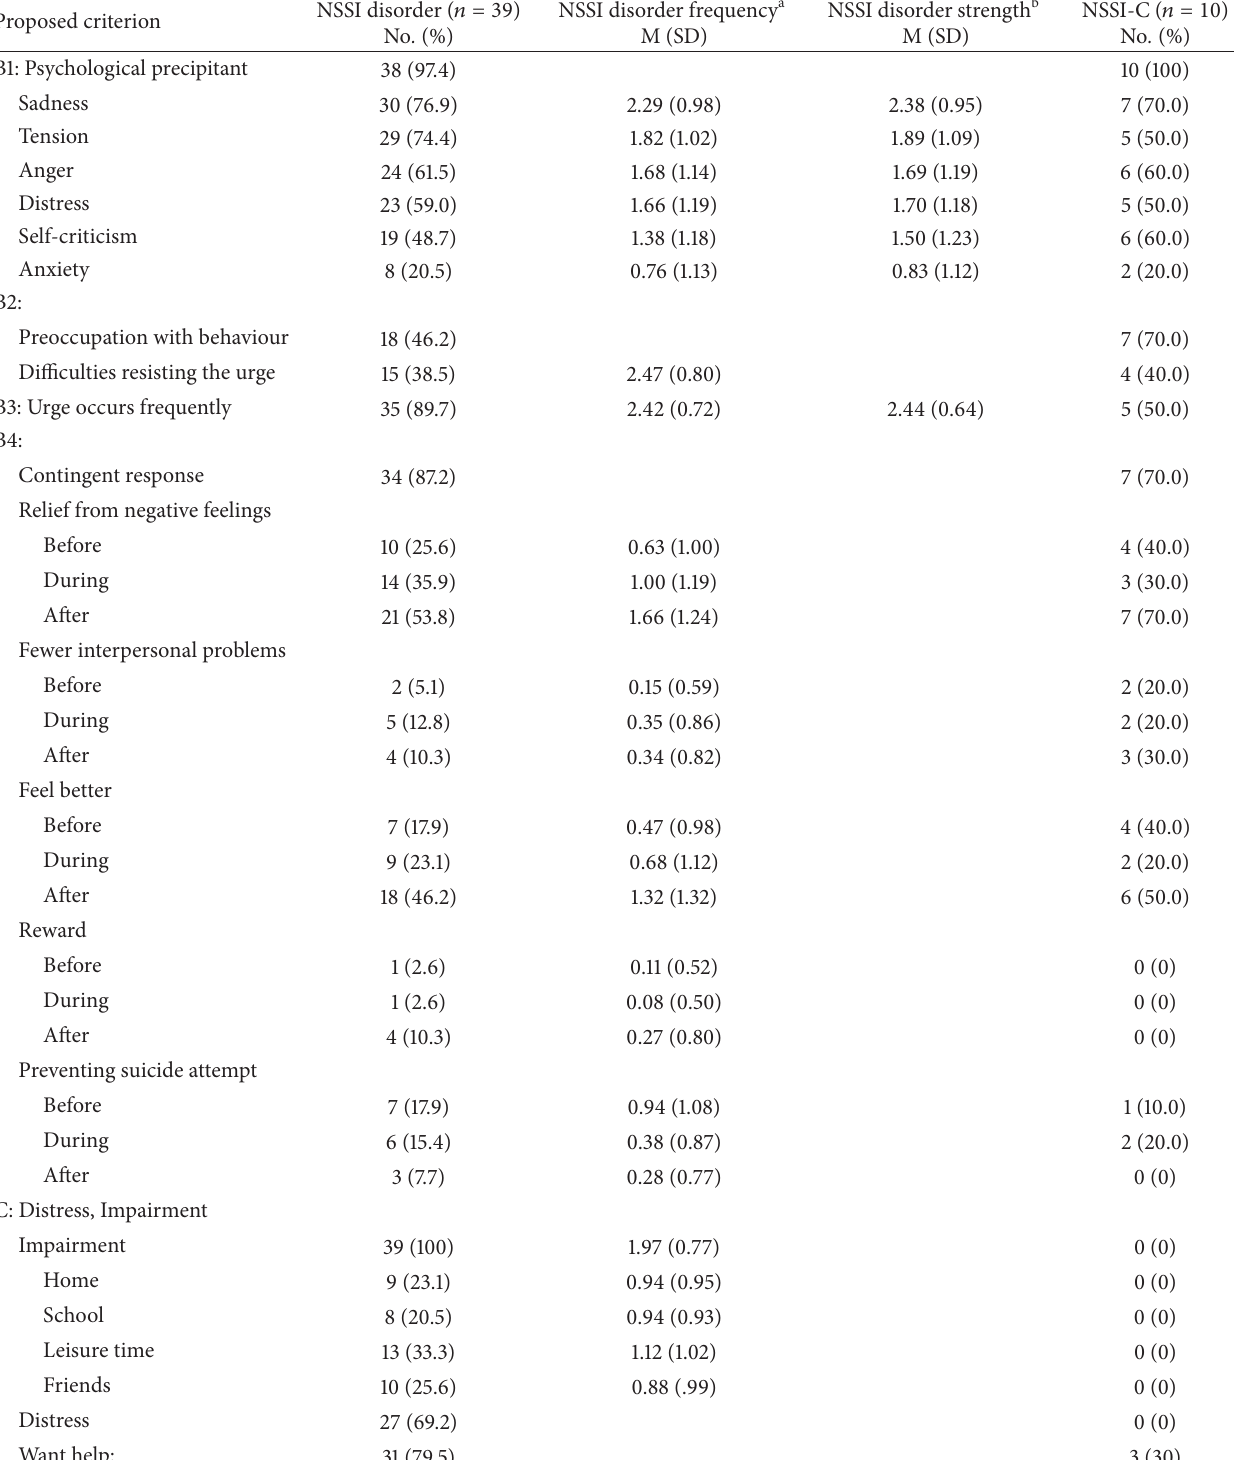
Table 2: Frequency and percentage of the proposed B and C diagnostic criteria for NSSI for the DSM-5, of adolescents with NSSI (NSSI disorder) and adolescents with NSSI without impairment/distress